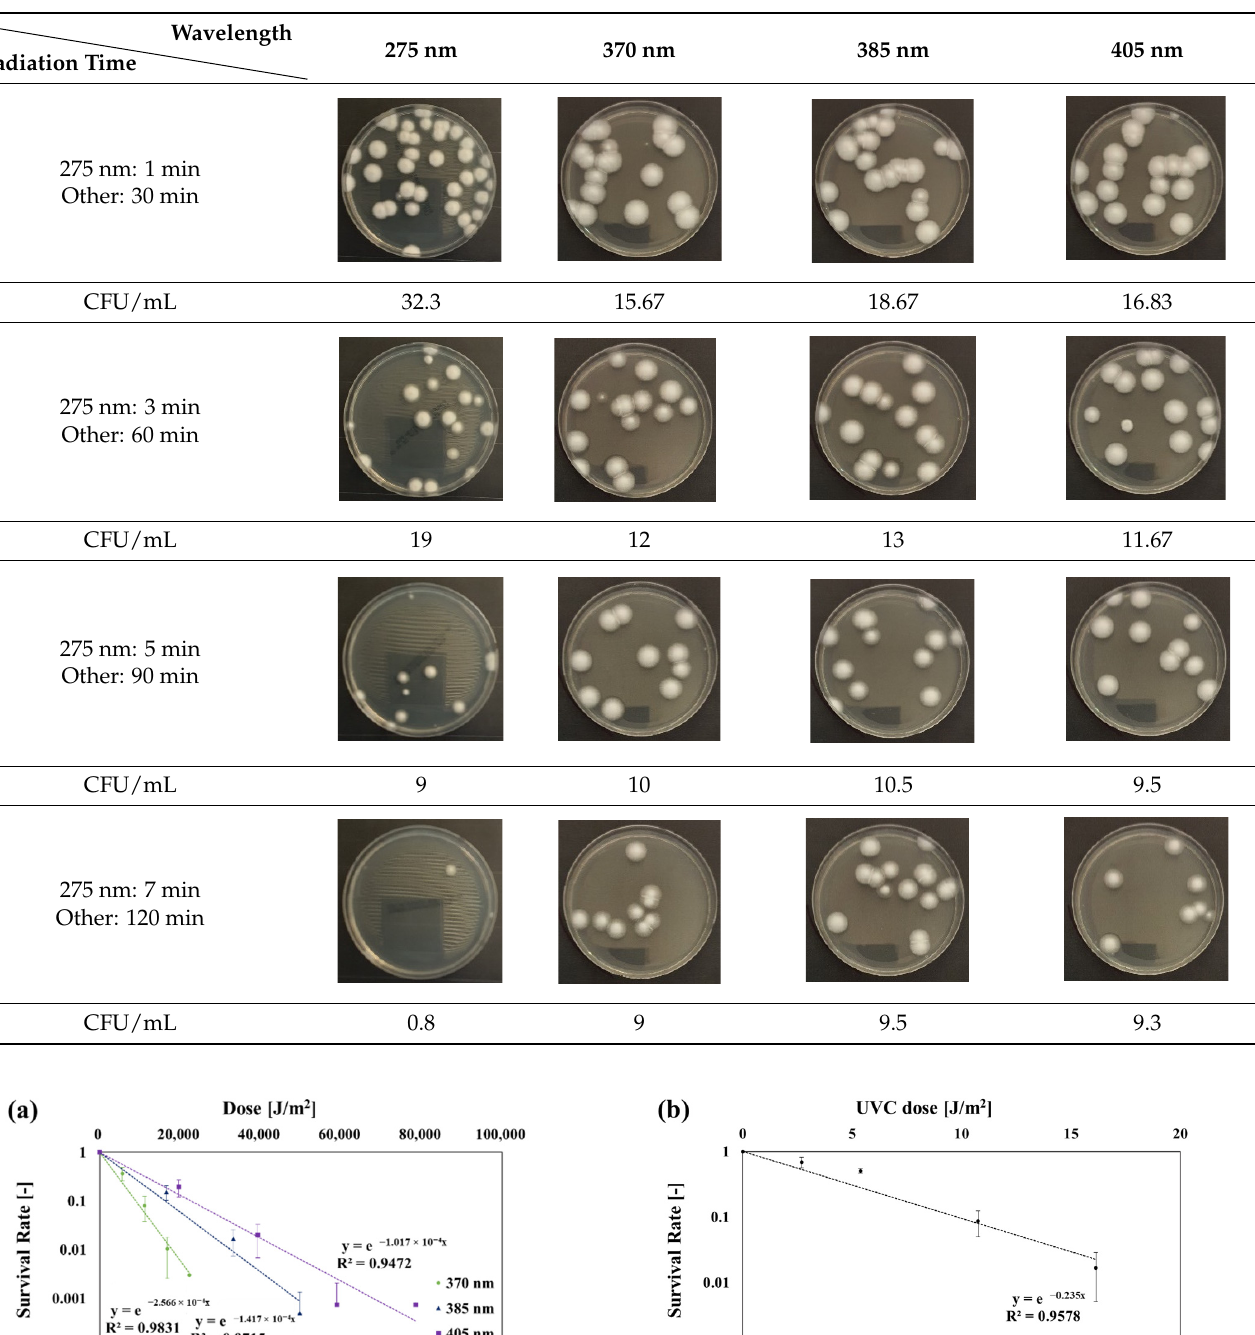
Figure 5. Inactivation curves of E. coli at each dose and wavelength: ( a ) 370, 385, and 405 nm; ( b ) 275 nm.